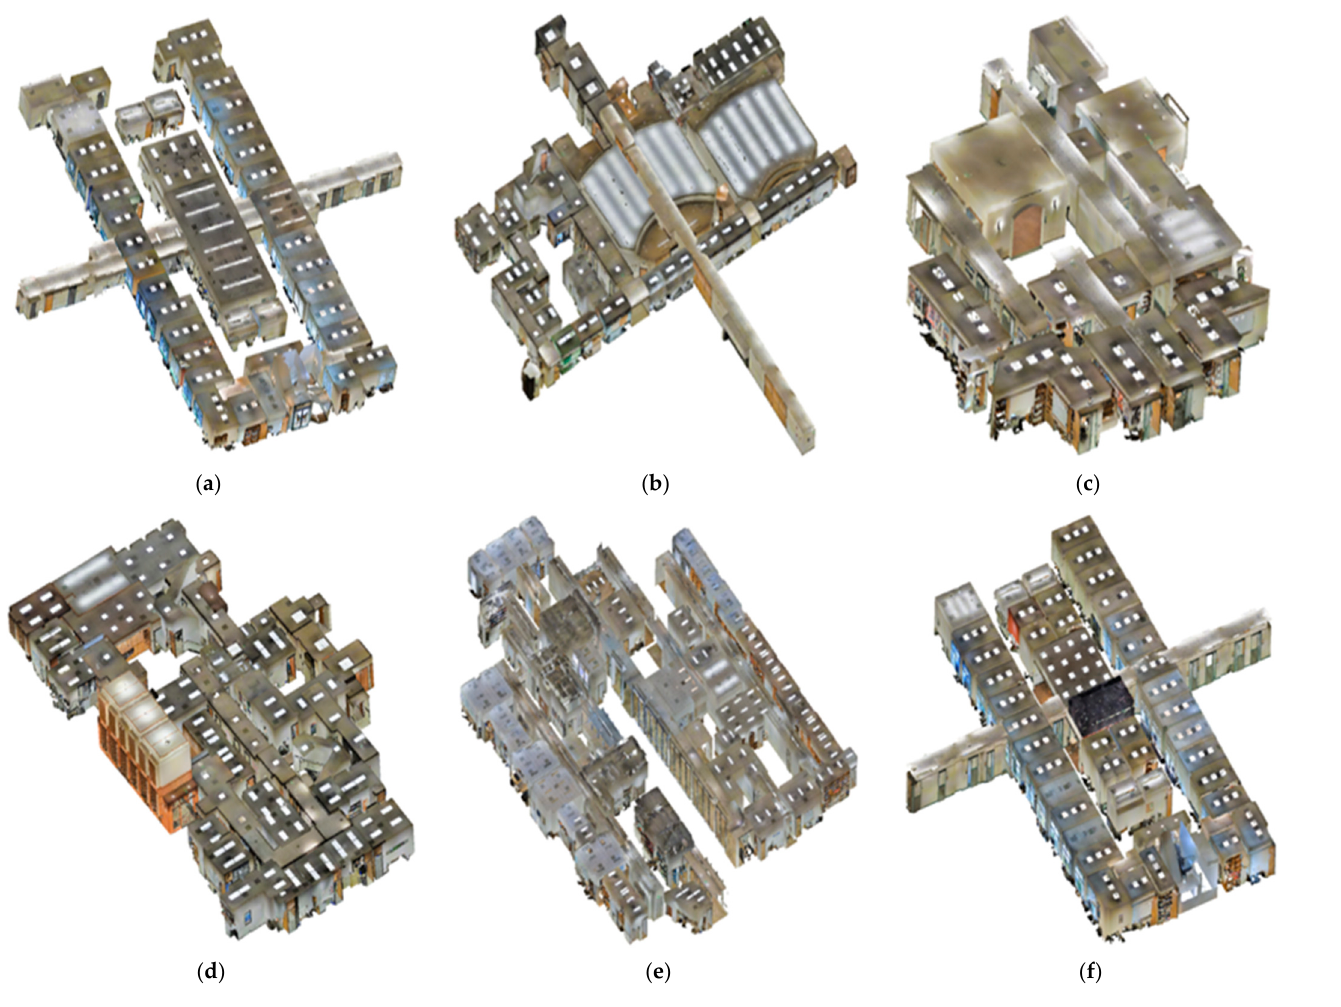
Figure 5. The S3DIS dataset: ( a ) Area 1; ( b ) Area 2; ( c ) Area 3; ( d ) Area 4; ( e ) Area 5; ( f ) Area 6.